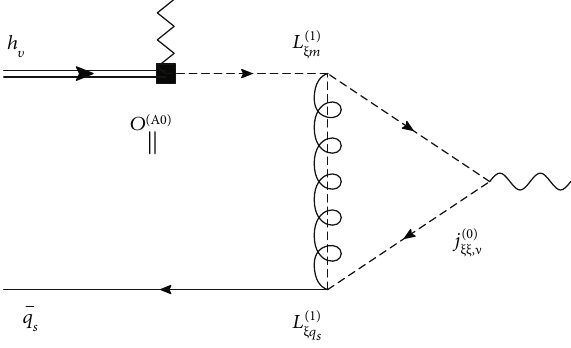
fi ned with the A 0 -type SCET operator ν , k ð p , q Þ de . q s